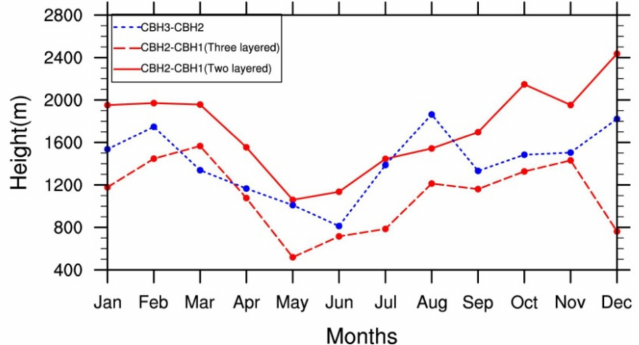
Figure 7. Distance between consecutive cloud base heights. The blue line shows the distance between the highest and middle CBH. The solid red line indicates the difference between the middle and the lowest CBH in the case of two-layered cloud systems as detected by the ceilometer, while the dashed red line indicates the same but for three-layered cloud